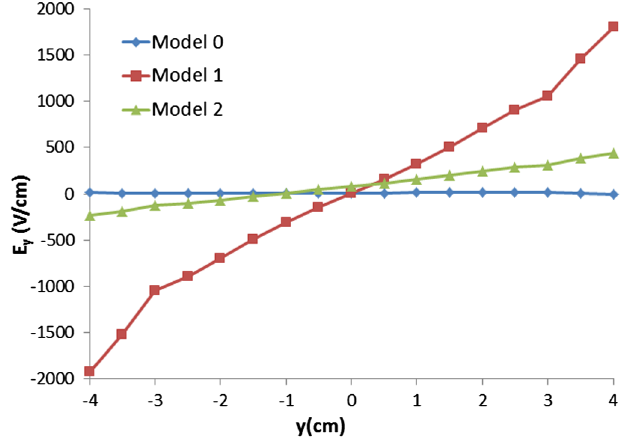
FIG. 9. y dependence of the E y distributions on the kicker central plane at z ¼ 1150 mm and x ¼ 0 mm for three models. [Figs. 5(b) and 5(c)]. Note that the left-handed system is used in these figures.